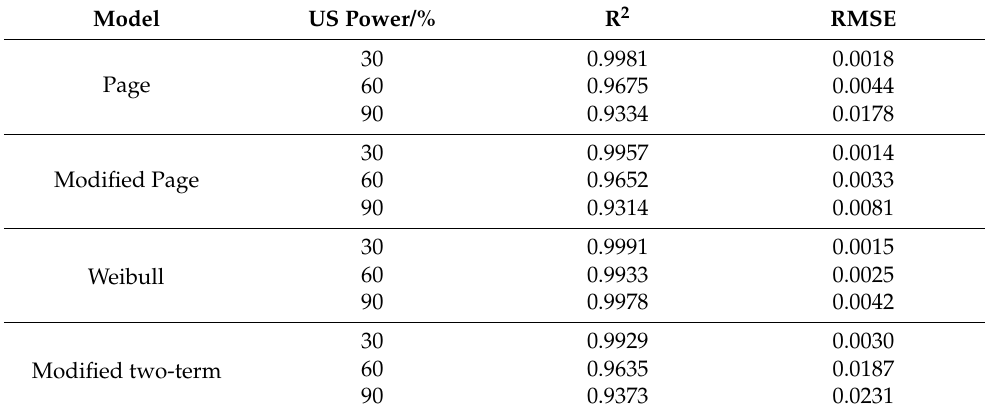
Table 3. Coefficient of determination and RMSE of selected mathematical models—45 min treatment.